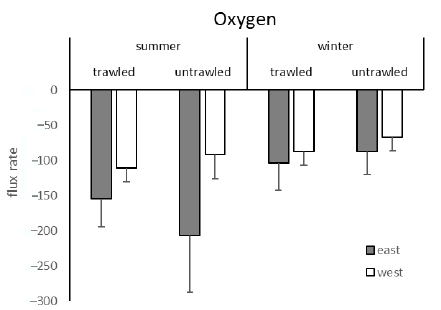
Figure 3. ( a ) Bottom water and ( b ) sedimentary chlorophyll a, phaeopigments and organic carbon from the Heraklion Bay trawled and untrawled sampling sites with mean and standard deviation in summer and winter. Grey bars indicate the eastern sites and white bars the western sites.